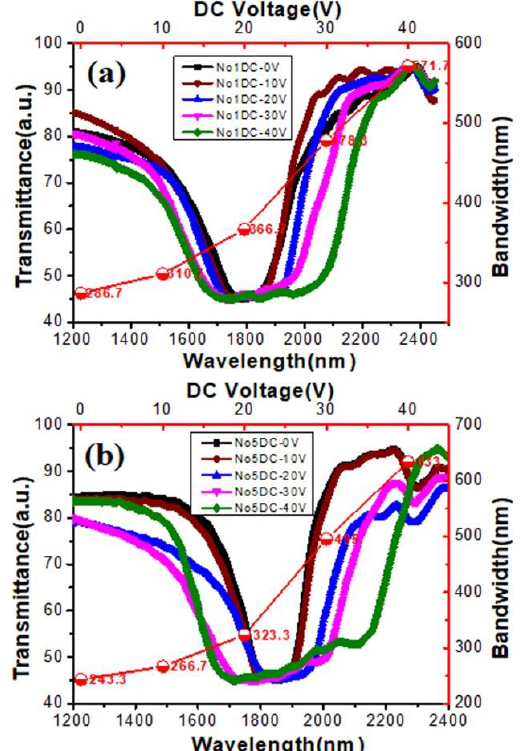
Figure 6. Influence of DC voltage intensity on the UV transmission spectrogram and reflection bandwidth of ( a ) sample 1 and ( b ) sample 5.